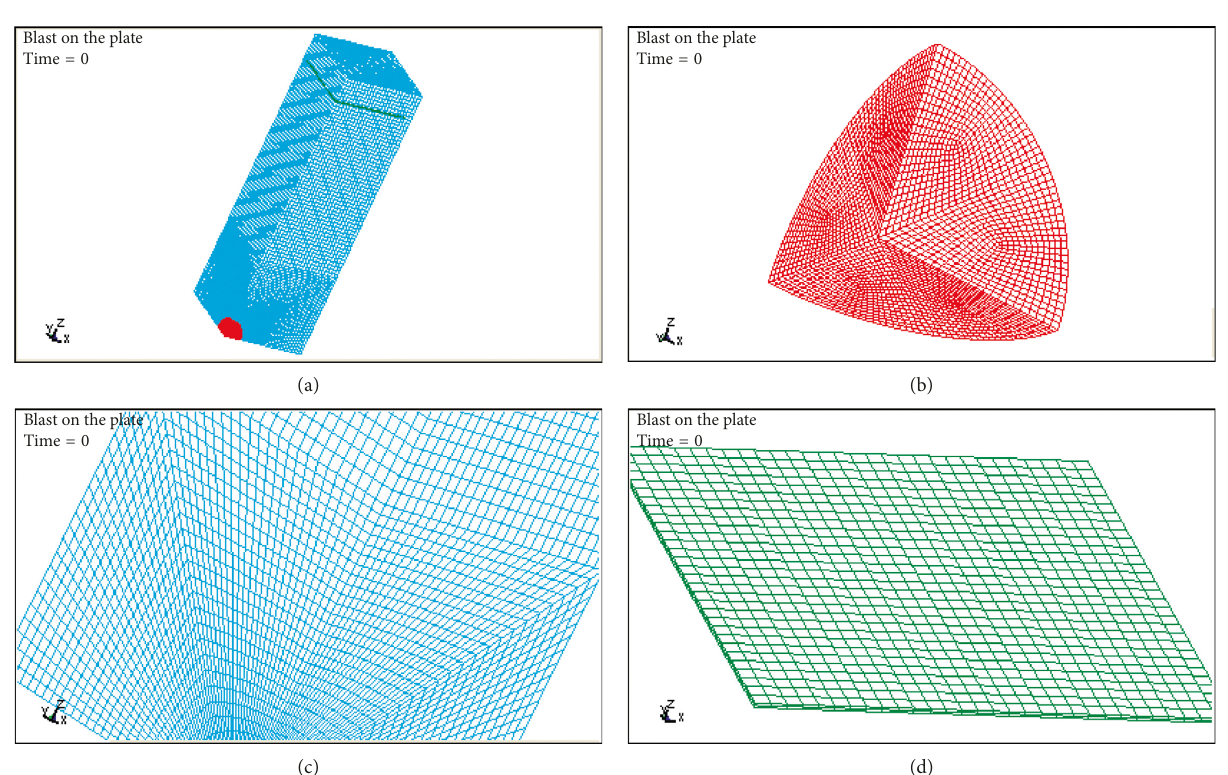
Figure 11: Finite element